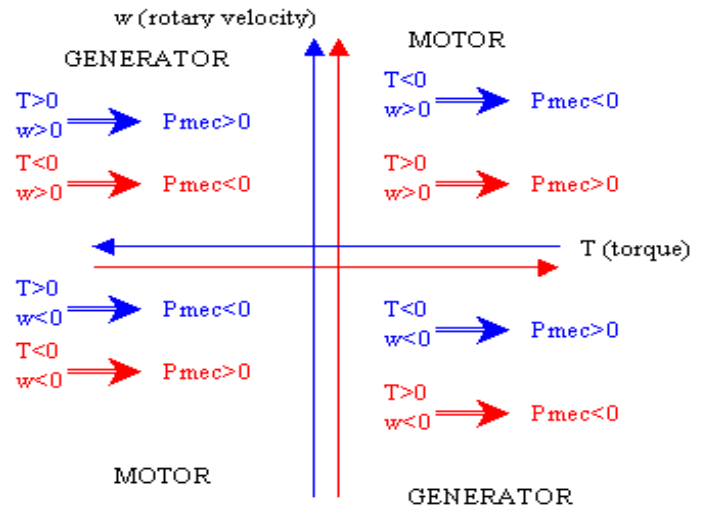
Figure 4. Electric motor operation.